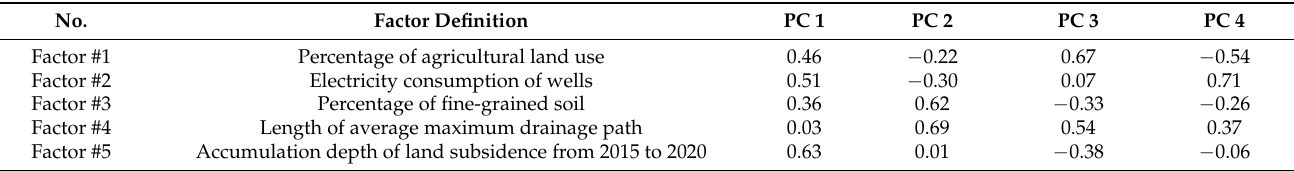
Table 5. The values of component loading in the PCA component matrix.